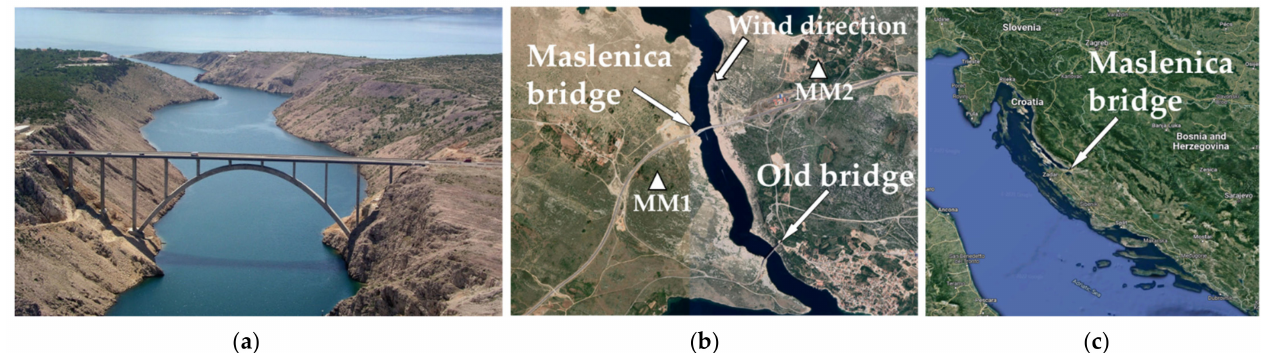
Figure 1. The Case Study—Maslenica Motorway Bridge: ( a ) view, ( b ) micro-location with meteoro- logical stations (MM1 and MM2), and ( c ) macro-location.